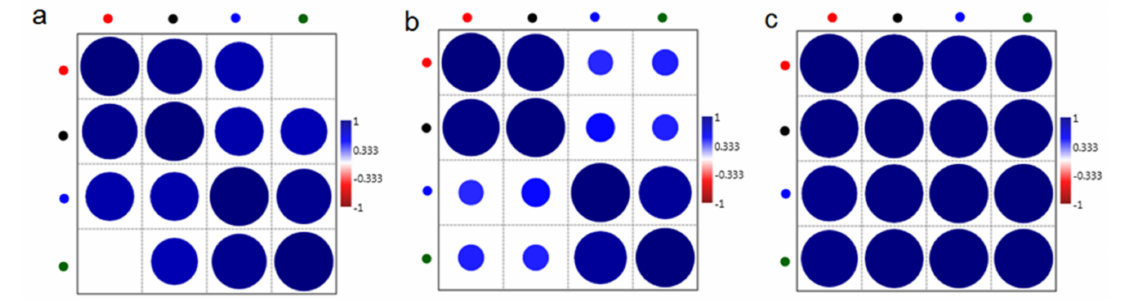
Figure 7. Pearson correlation test for selected IR region ( a ) (800 cm − 1 –1800 cm − 1 —fingerprint), ( b ) (1000 cm − 1 –1300 cm − 1 — carbohydrates) and ( c ) (2700 cm − 1 –3000 cm − 1 —lipids) of summer (green dot) and winter months: October (red dot), November (black dot), December (blue dot) and of C. tujafilina